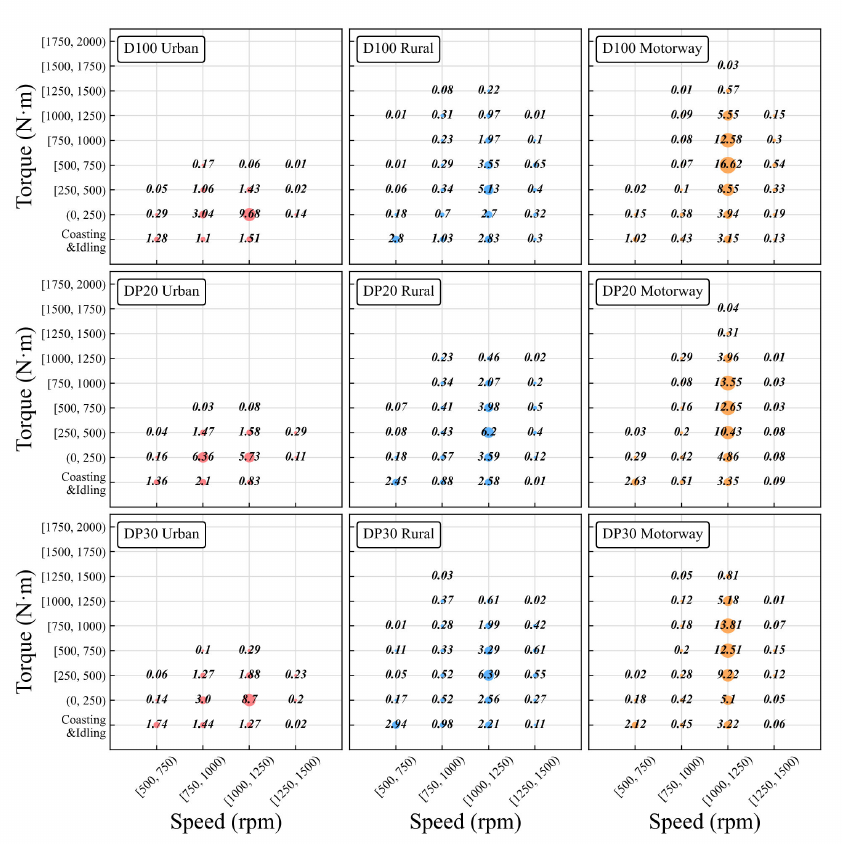
Figure 6. The percentage of time at each engine operating range for all three driving conditions under the corresponding fuel condition.